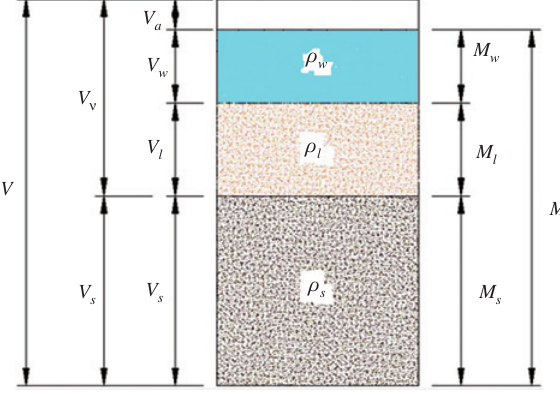
Figure 1 Phase diagram of S-CaL-W